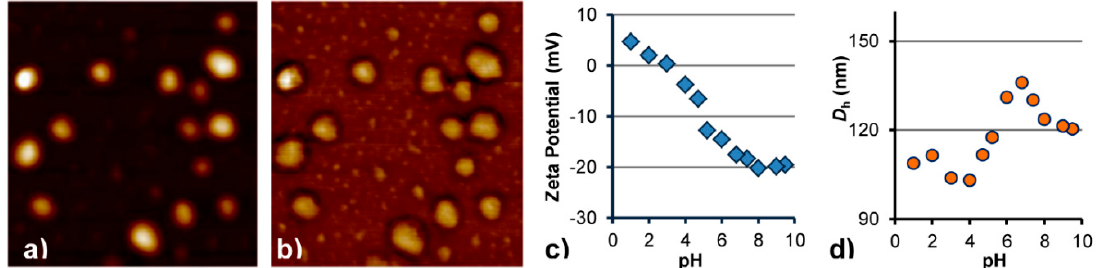
Figure 3. AFM ( a ) height and ( b ) phase images for MPIC micelles G1@Fe 3 O 4 @PAA 27 - b -PHEA 260 at f = 0.5. The scale of the AFM images is 500 × 500 nm 2 . ( c ) Zeta potential and ( d ) Intensity-weighted hydrodynamic diameter D h of mentioned MPIC micelles as a function of pH.